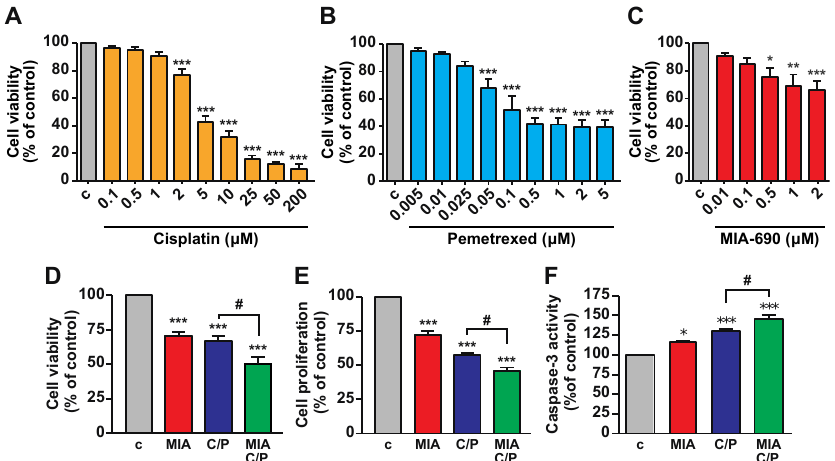
Figure 1. Inhibitory effects of cisplatin, pemetrexed and MIA-690, alone or in combination, in PM cells. Cell viability, assessed by MTT in MSTO-211H cells cultured for 48 h in DMEM containing 2.5% serum in either absence (c, control) or presence of cisplatin ( A ), pemetrexed ( B ) or MIA-690 ( C ) at the concentration indicated. Results, expressed as percent of control, are means ± SEM. * p < 0.05, ** p < 0.01 and *** p < 0.001 vs. c by one-way ANOVA and Dunnet’s multiple comparison post- hoc test ( n = 5); each condition was performed in quintuplicate. Cell viability ( D ), cell proliferation ( E ) and apoptosis ( F ) assessed by MTT, BrdU and caspase-3 activity assays, respectively, in MSTO-211H cells cultured in DMEM + 2.5% serum either without (c, control) or with 1 µ M MIA-690 (MIA), 2 µ M cisplatin/50 nM pemetrexed (C/P) or the three compounds in combination (MIA/C/P), at the same concentrations. Results, expressed as percent of control, are means ± SEM. * p < 0.05, *** p < 0.001 vs. c; # p < 0.05 by one-way ANOVA and Tukey’s multiple comparison post-hoc test ( n = 6 for D and n = 4 for E and F ); each condition was performed in quintuplicate.